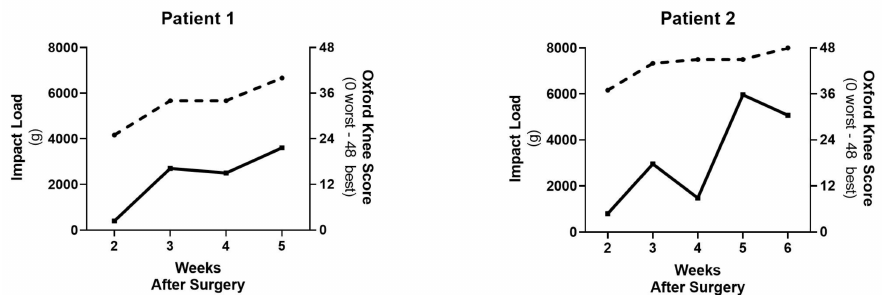
Figure 5. Individual data for Patient 1 and 2 with PROMs scores (OKS, dashed line) and IMU Outputs (Impact Load, solid line) over the post-operative period.